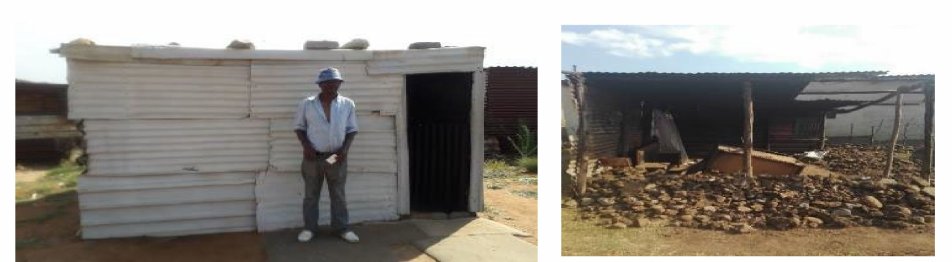
Figure 8. A typical backyard shack in Wakkerstoom (left), this housing type is not seen as a permanent dwelling, as evidenced by occupants dismantling it shortly after receiving an RDP from the government (right). The homes were occupied by one to three occupants. The homes were constructed with mainly corrugated iron, mud blocks as well as other scavenged or cheap materials. The homes generally had a floor area of 20–30 m 2